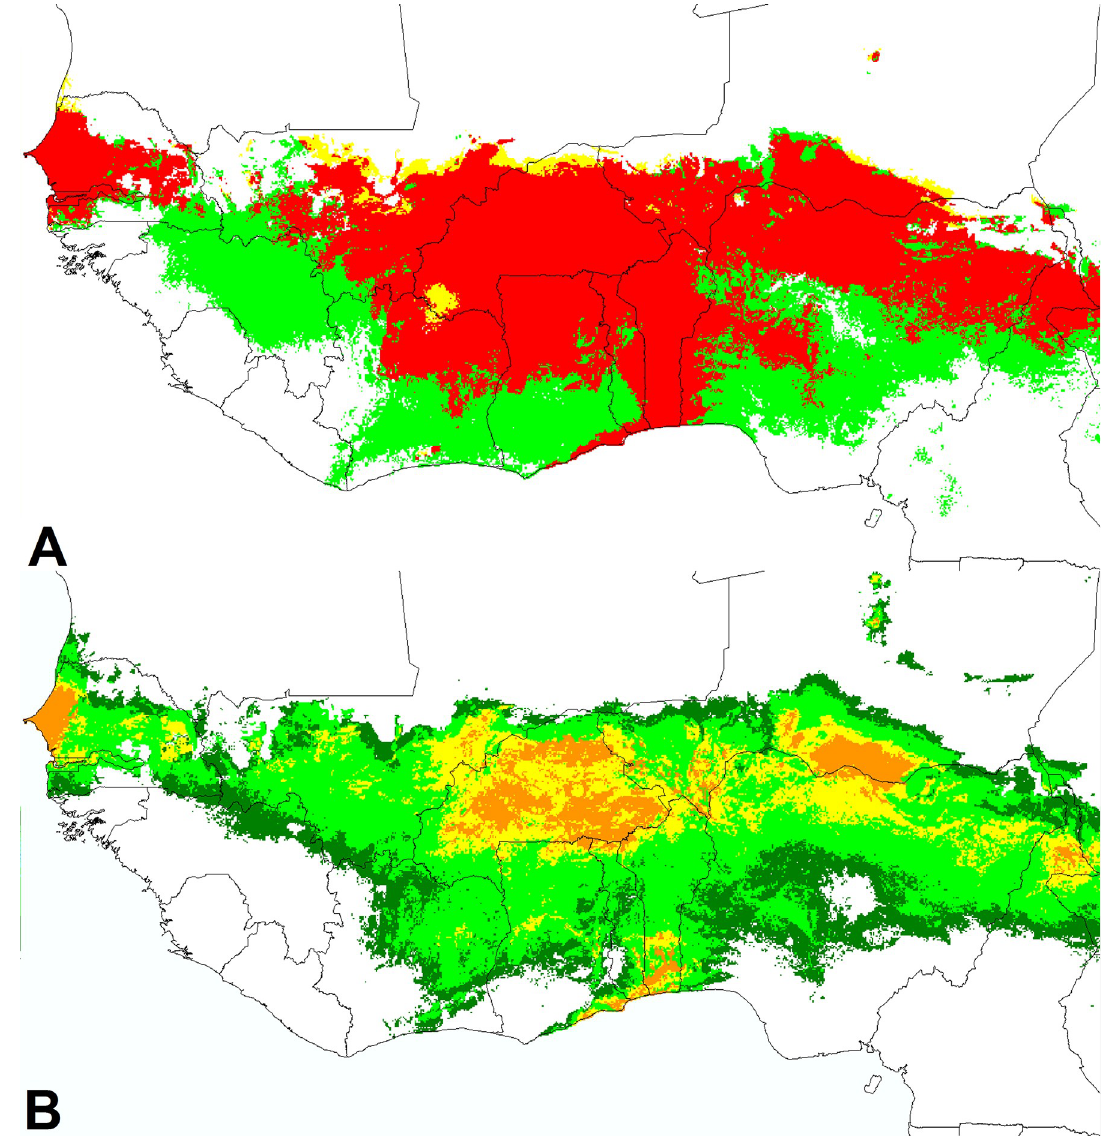
Fig 5. Models of distribution for infestation of cultivated cowpea by S . gesnerioides . A. Superposition of Maxent models for the crop (as presented in Fig 1B) and its parasite (as presented in Fig 3C); green areas: favorable only for cowpea cultivation; yellow areas: favorable only for S . gesnerioides ; red areas: favorable for both species. B. Distribution model derived directly from observations of cultivated cowpea infestations (color code as for Fig